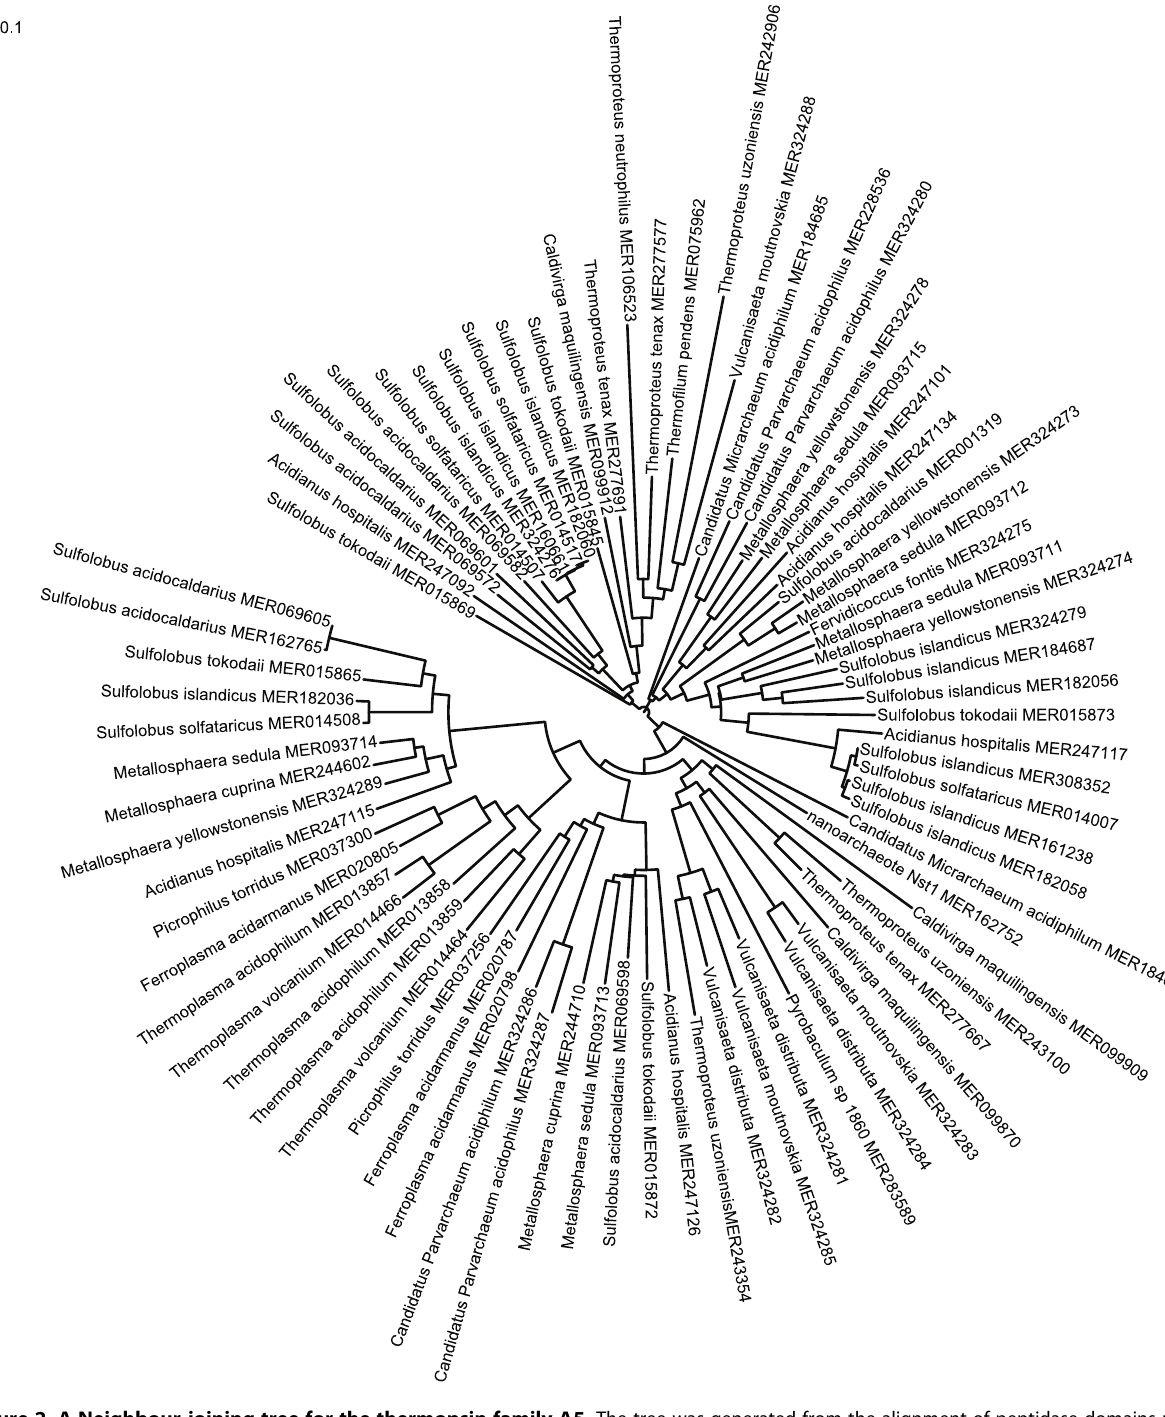
Figure 2. A Neighbour-joining tree for the thermopsin family A5. The tree was generated from the alignment of peptidase domains using FastTree. Labels are species names and sequence identifiers from the MEROPS database. Classification is indicated by coloured dots: yellow=Sulfolobales; red=Euryarchaeota; dark blue=Nanoarchaeota; light blue=Thermoproteales; green=Fervicoccales. The probable root is indicated by a black